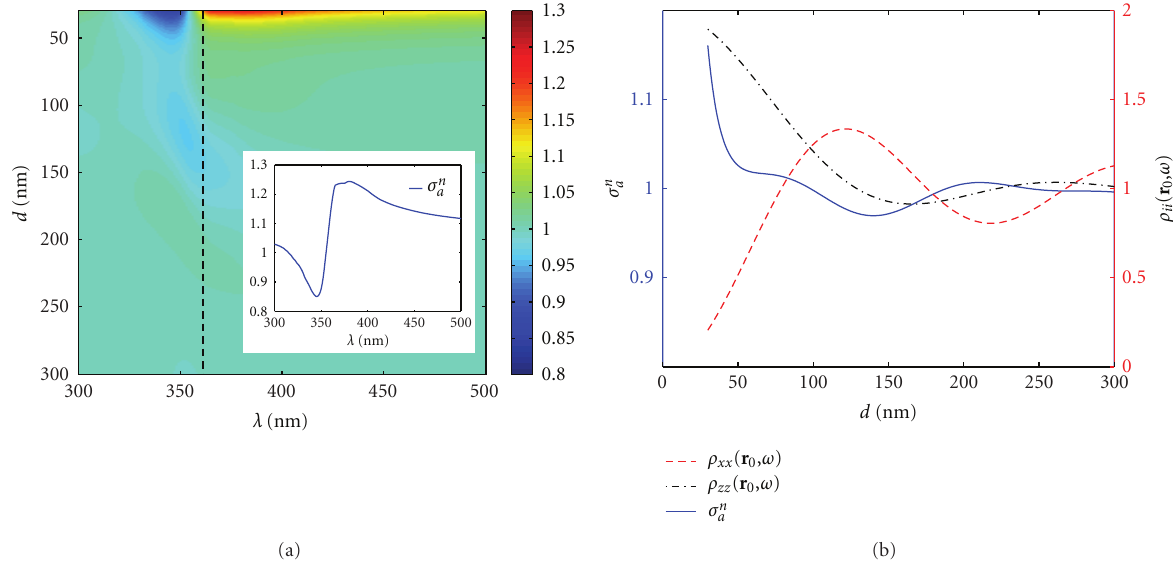
Figure 5: (a) same as Figure 4 for an illumination with a p -polarized plane wave, at an angle of incidence θ = 45 o . Both the partial LDOS ω ) and ρ ω ) are displayed in (b) since both influence the generalized cross-section in this ρ xx ( r 0 , zz ( r 0 ,